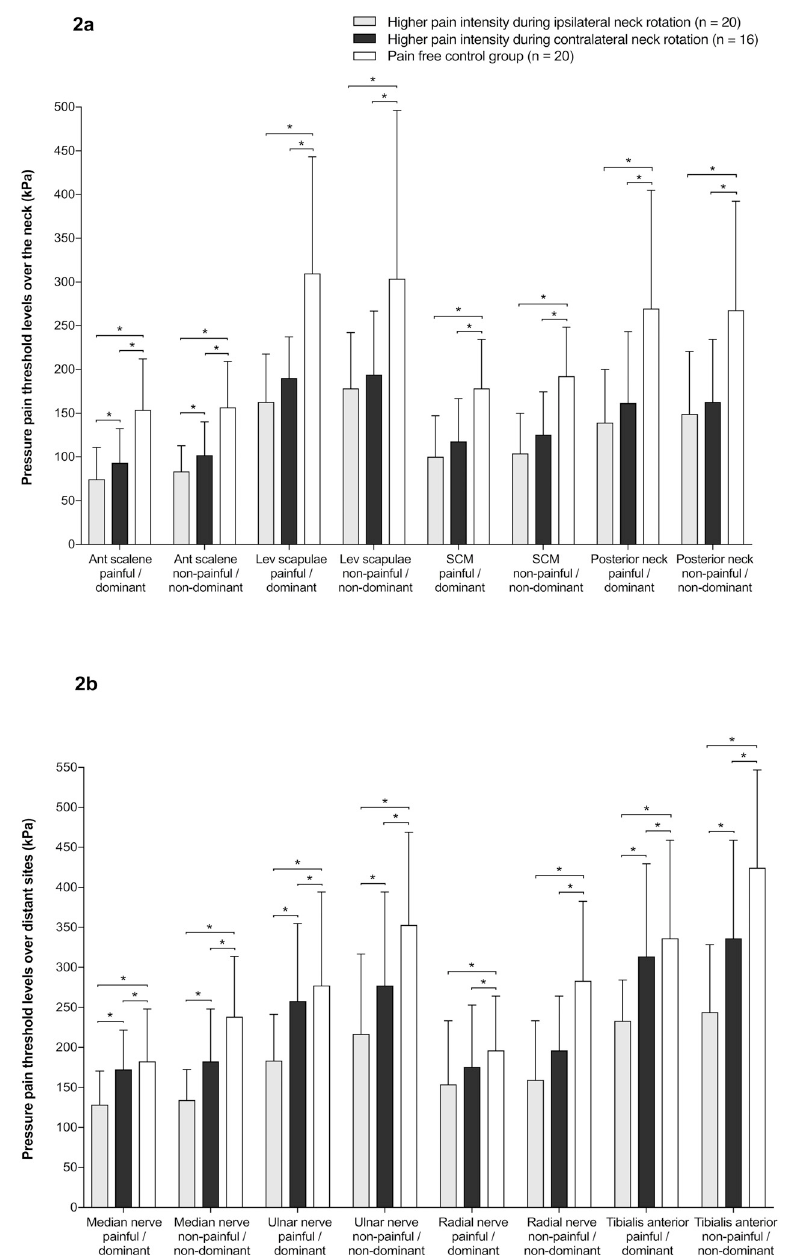
Figure 2. ( a ) Mean ± standard deviation (kPa) of the pressure pain threshold levels over the neck (the painful / dominant side and the non-painful / non-dominant side) in the study groups (*, p < 0.05). SCM, sternocleidomastoid muscle. ( b ) Mean ± standard deviation (kPa) of the pressure pain threshold levels (the painful / dominant side and the non-painful / non-dominant side) over distant sites in the study groups (*, p < 0.05).